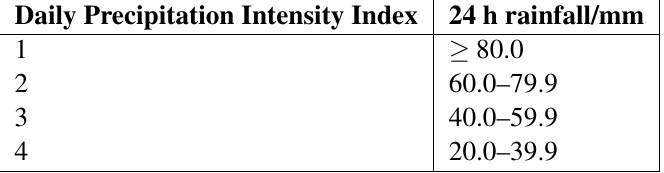
Table 1 Evaluation standard of daily precipitation intensity index